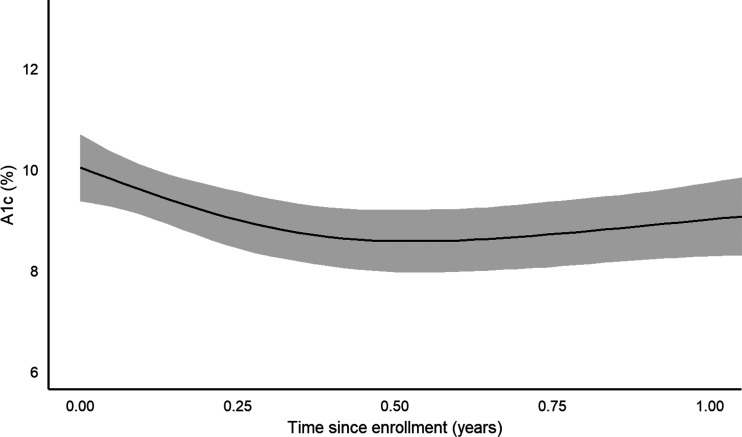
Estimated Change in Hemoglobin A1c Over Time After Enrollment in Rural Diabetes Care Program, Guatemala